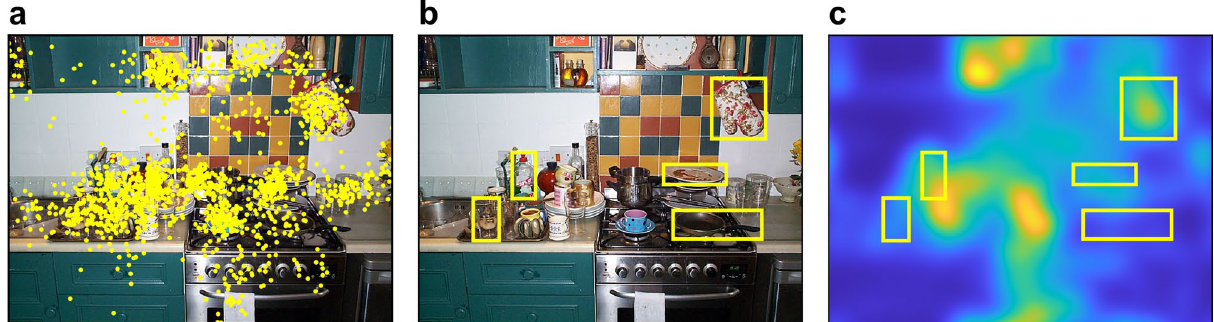
Figure 1. Real-world scene with all fixations from all 76 observers overlaid as yellow dots ( a ) and with tagged object bounding boxes represented by yellow rectangles ( b ). The salience map (Adaptive Whitening Saliency) for this image is shown in ( c ), where brighter colours correspond to higher visual salience; the object bounding boxes from ( b ) are additionally displayed. The depicted photograph was taken by George L. Malcolm.